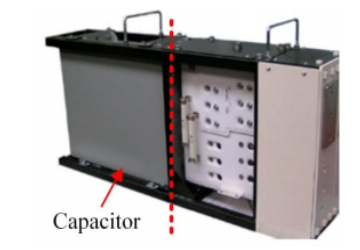
Figure 5. Submodule of